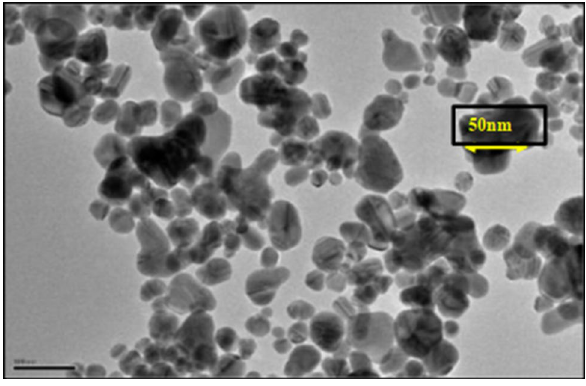
Fig. 3 TEM image of ZnO